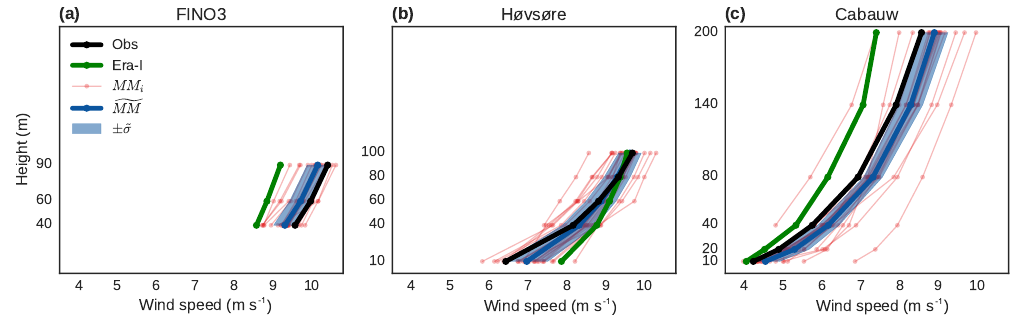
Figure 3. Vertical profiles of mean wind speed ( u m ) at the three sites for the observations (black), the ERA-Interim data set (green), the mesoscale models MM i (red), and the inter-model mean g MM (blue line), and its standard deviation ± e σ (blue